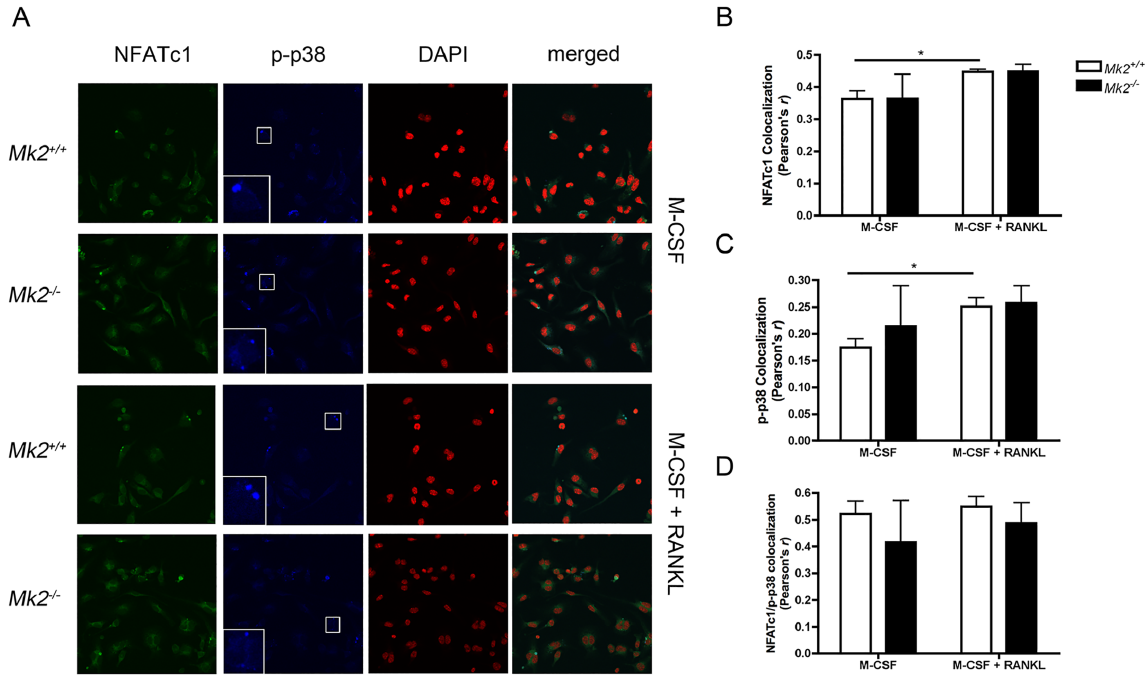
Fig 4. MK2 deficiency does not regulate NFATc1 colocalization. (A) Representative confocal images of male dOCP lo cells treated with M-CSF (control) or M-CSF and RANKL for 30 minutes. A 3x magnified portion of p-p38 was inset (middle,left). (B) Pearson ’ s r correlation coefficients for NFATc1 and DAPI colocalization. (C) Pearson ’ s r correlation coefficients for p-p38 and DAPI colocalization. (D) Pearson ’ s r correlation coefficients for NFATc1 and p-p38 colocalization. Data are expressed as means ± SE compared to Mk2 +/+ controls ( * P (cid:1) 0.05).